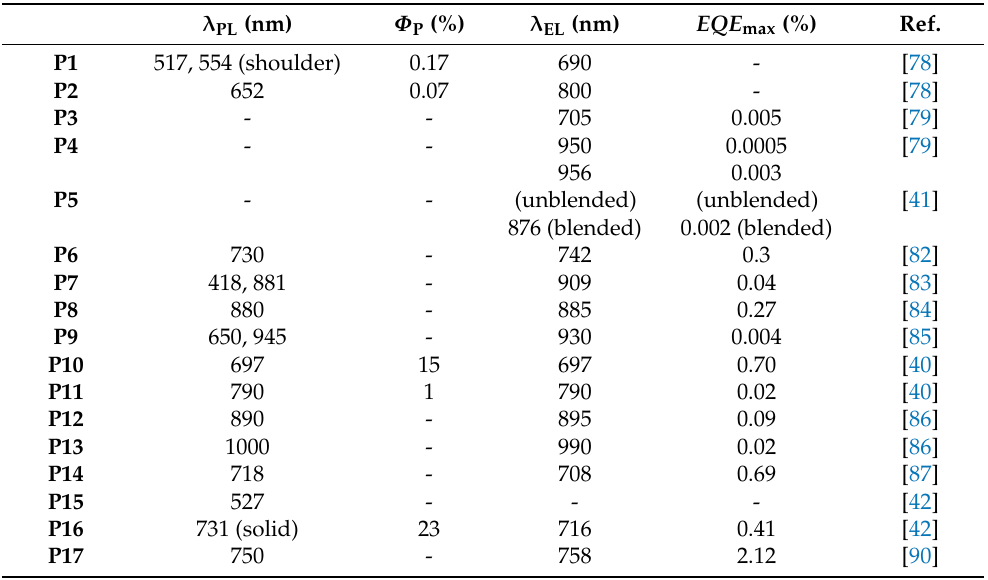
Table 1. Photophysical and electroluminescent properties of some NIR conjugated